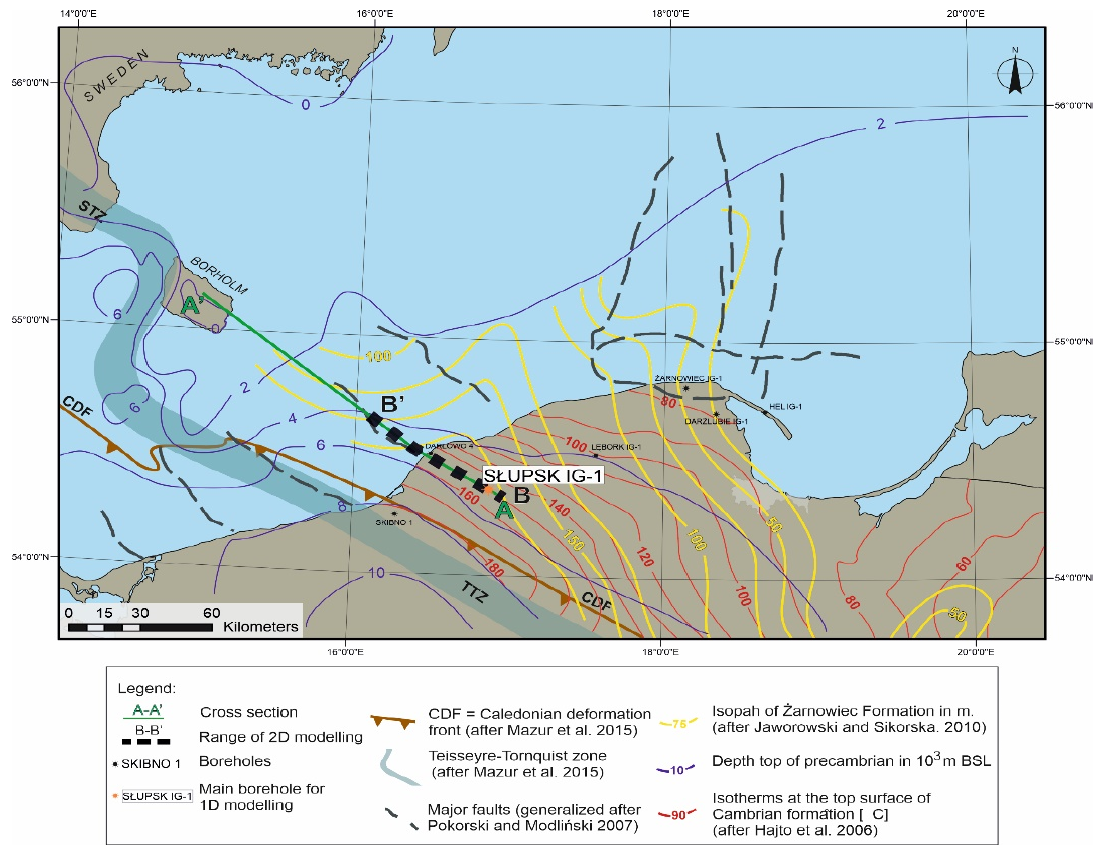
Figure 2. Geological-tectonic map of sub-Permian surface in the southwestern part of the Baltic Basin (after [15], fragment). Thick green line indicates modeled A’-A cross-section. Thick, black dashed line indicates range of 2D modelling (B’-B).